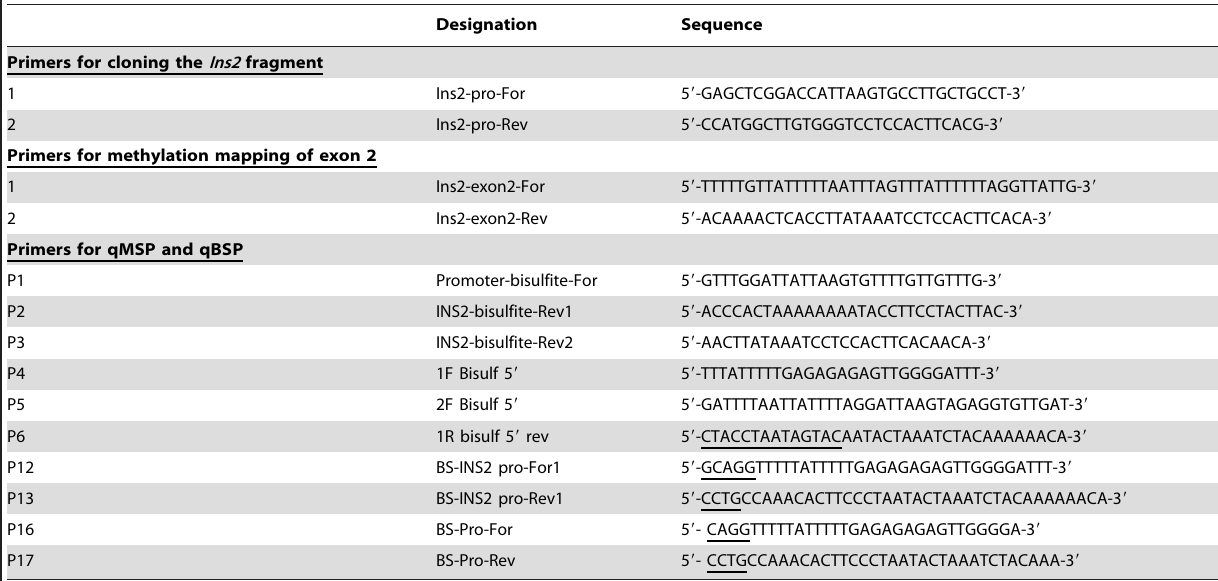
Table 1. Oligonucleotides used in this